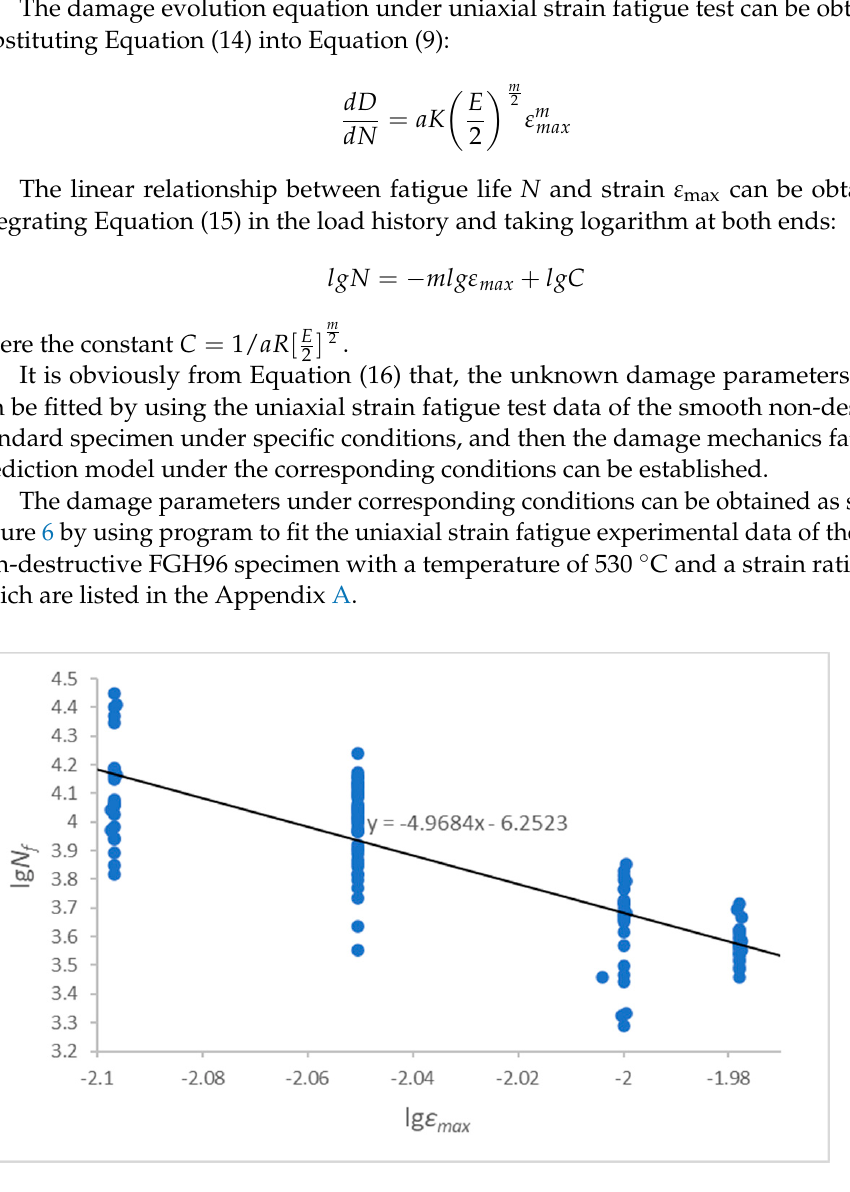
Figure 6. Fitting of damage parameters when R = 0.05.